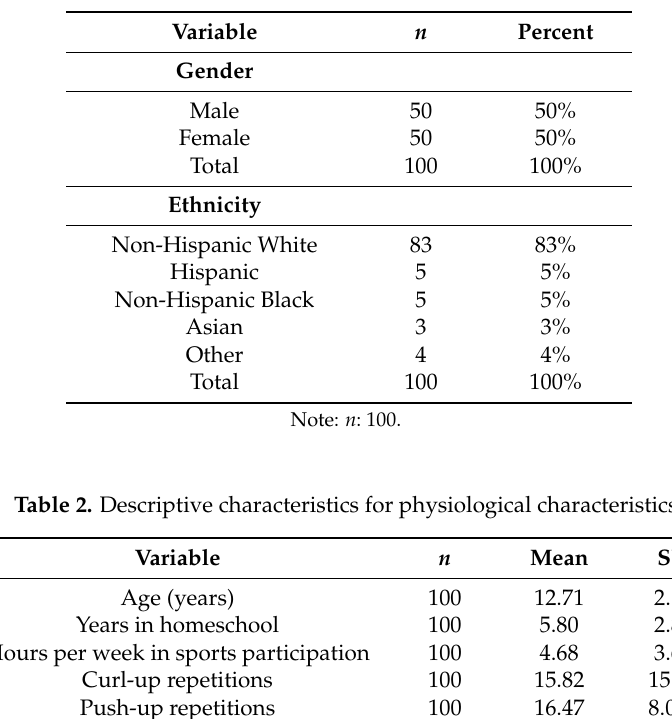
Table 2. The sample was evenly split between genders with an average age of 12.71 years. They were predominantly non-Hispanic white and of normal body mass index. Table 1. Frequencies for participant characteristics.